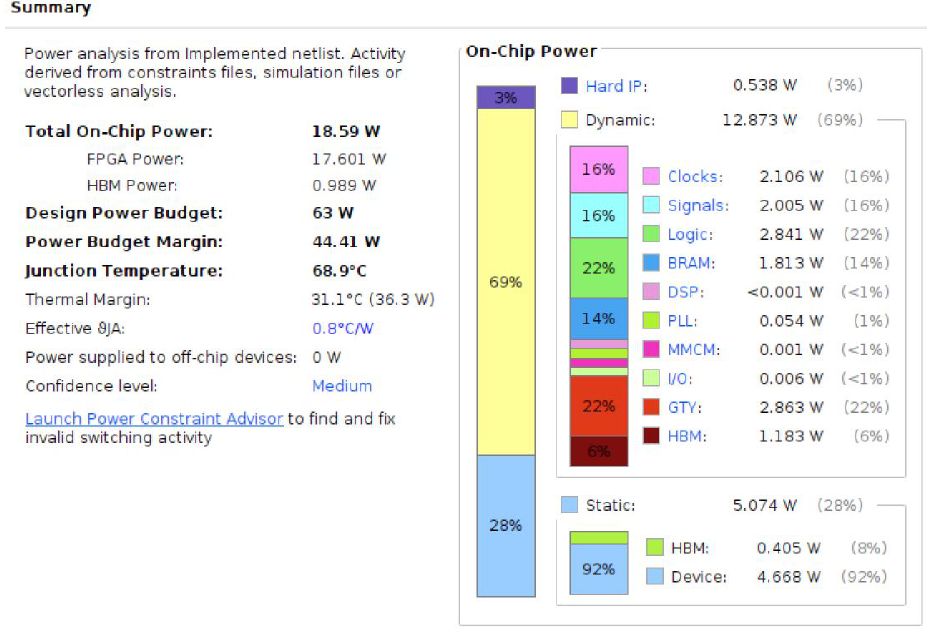
Figure 12. Power consumption results of Alveo U50 Accelerator during the hardware implementation for Memory-Tree